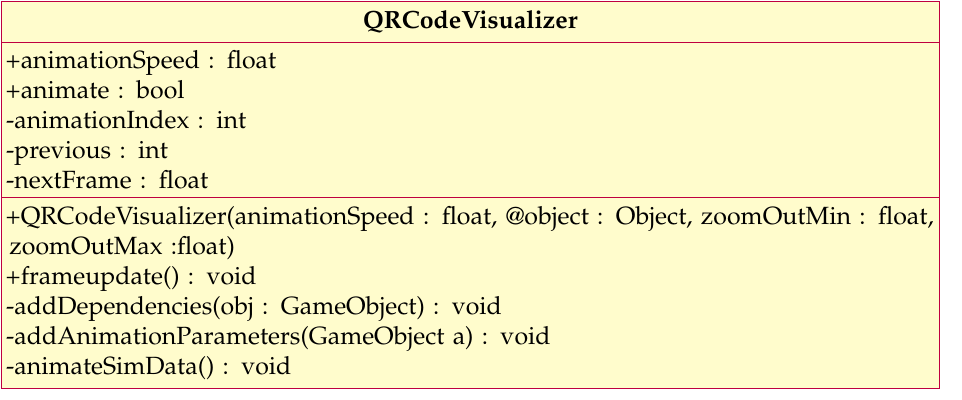
Figure 12. Class diagram of the QRCodeVisualizer with all relevant fields and functions regarding